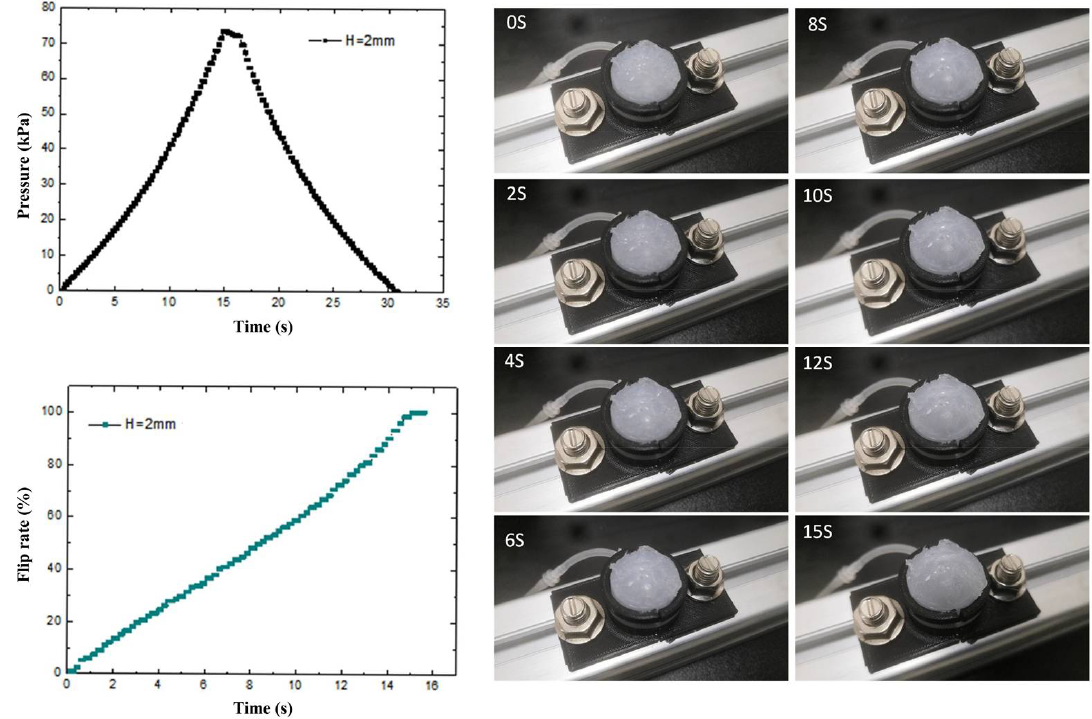
Figure 9. Curves of flat film driving process, pressure time variation and loading flip rate.